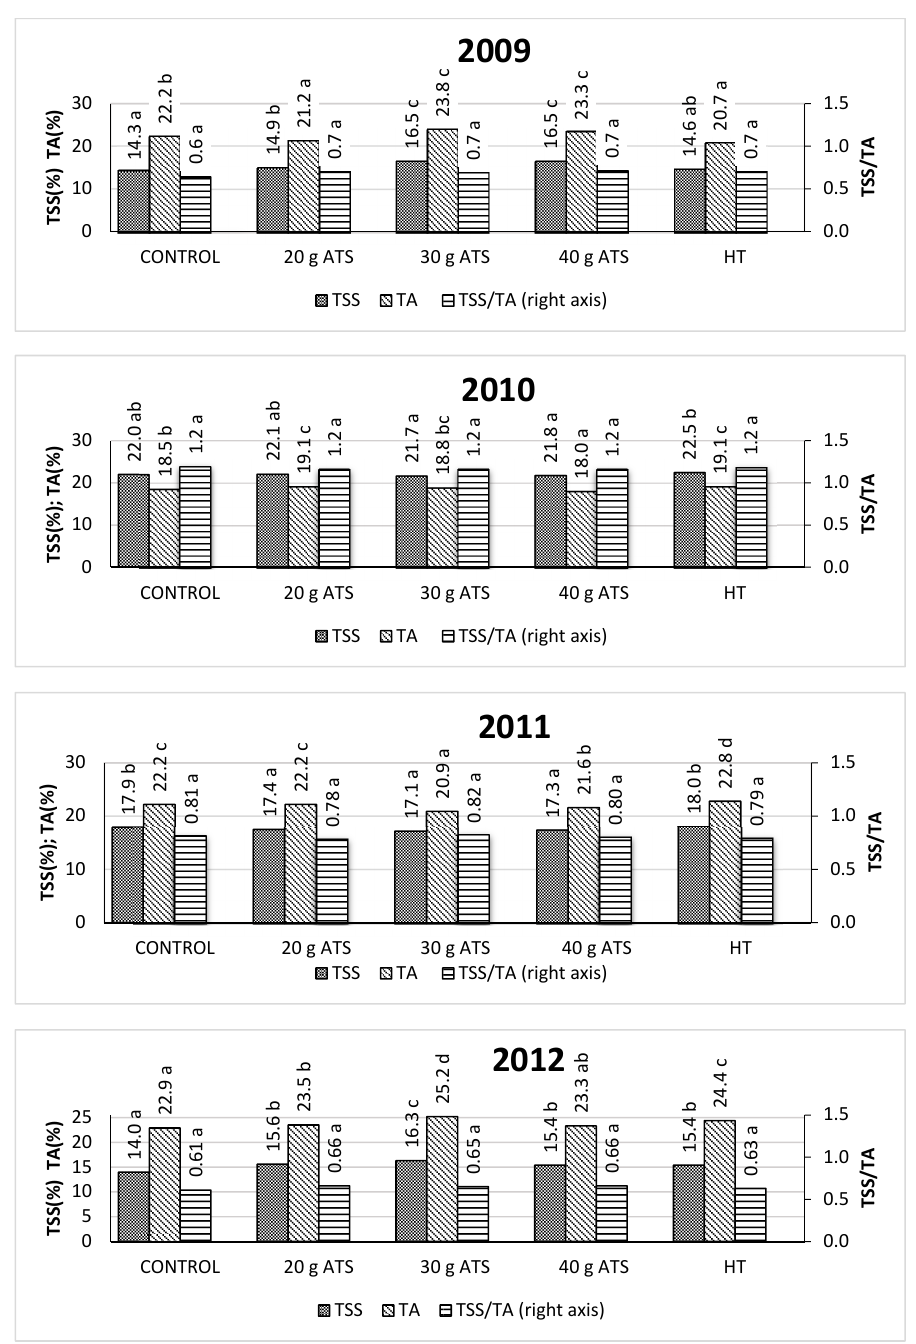
Figure 6. The effect of thinning on total soluble solids (TSS), titratable acidity (TA) and TSS/TA ratio of ‘Regina’ sweet cherry fruit in 2009, 2010, 2011 and 2012. 1 One-way analyses of variance; data in bars filled with the same pattern, marked with the same letter, are not significantly different at α = 0.05 (Duncan’s test).